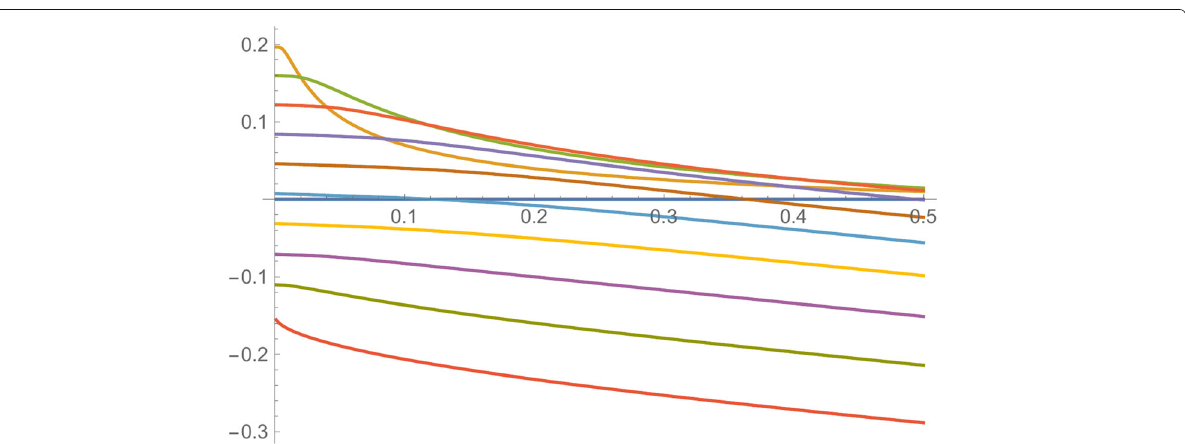
Fig. 12 Mathematica simulation of v 3 ( z , t ) for z ∈ { 0,0.1, ... ,0.9,1 } with the order in the same color scheme as in Fig. 11 for A 1 = A 2 = 0 and the other parameters with the values of Table